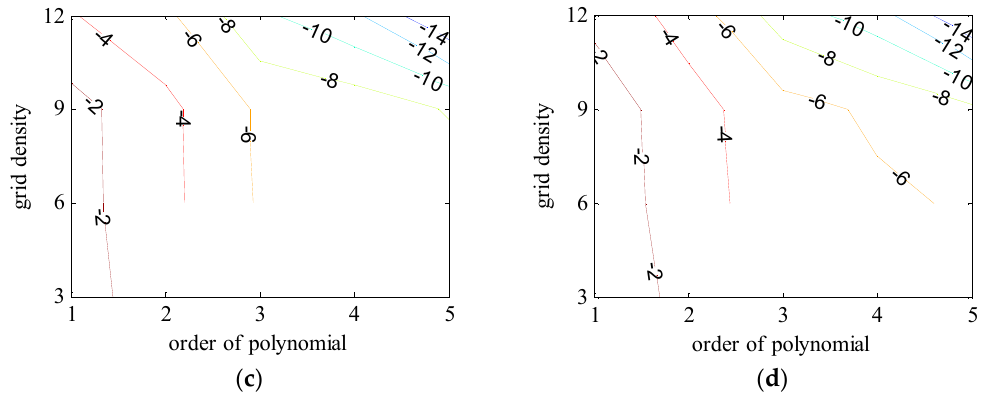
Figure 8. The fitted error of PMs of order 1 to 5 in two test areas with knot density of 3, 6, 9 and 12. ( a ) lg(RMS) of xi in North China Plain; ( b ) lg(RMS) of eta in North China Plain; ( c ) lg(RMS) of xi in the Himalayas; ( d ) lg(RMS) of eta in the Himalayas.